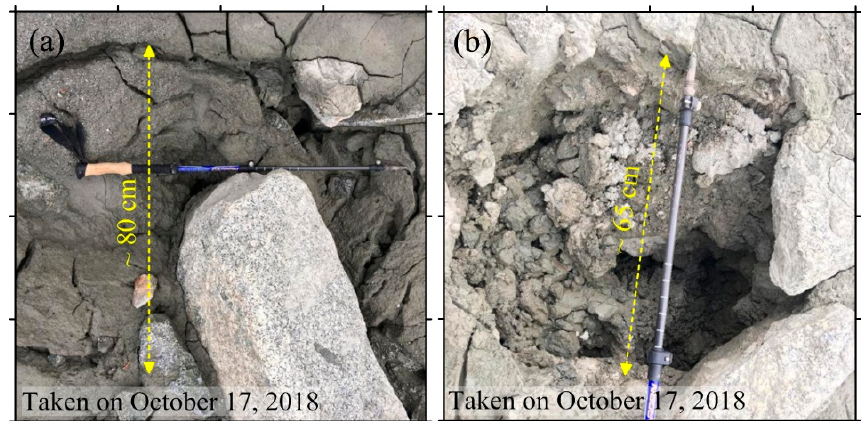
Figure 10. Photos of the DGL on the field survey on 17 October 2018. ( a , b ) show the two entrances of the drainage tunnel at the basin of the DGL. The yellow dotted lines show the estimated entrance radius.